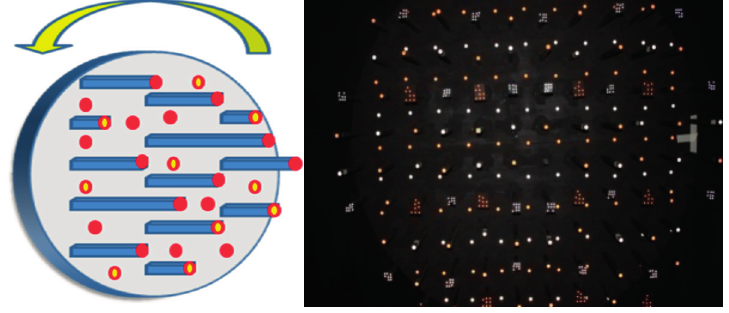
Figure 11. The camera control